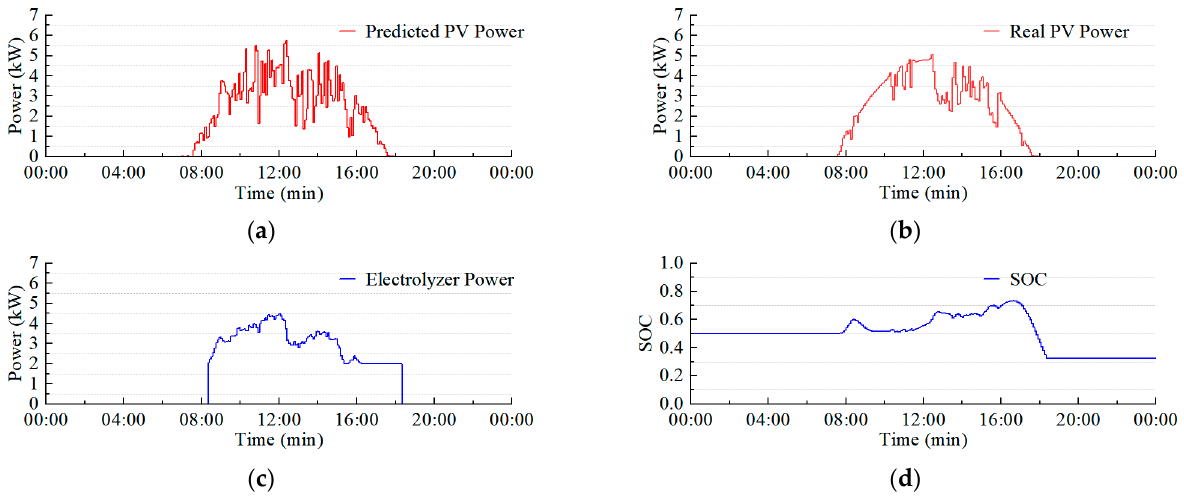
Figure 9. System status using proposed energy management strategy on day 2 with prediction error. ( a ) The predicted PV power; ( b ) the actual PV power on day 2; ( c ) the electrolyzer power during the day; ( d ) daily change of the battery SOC.